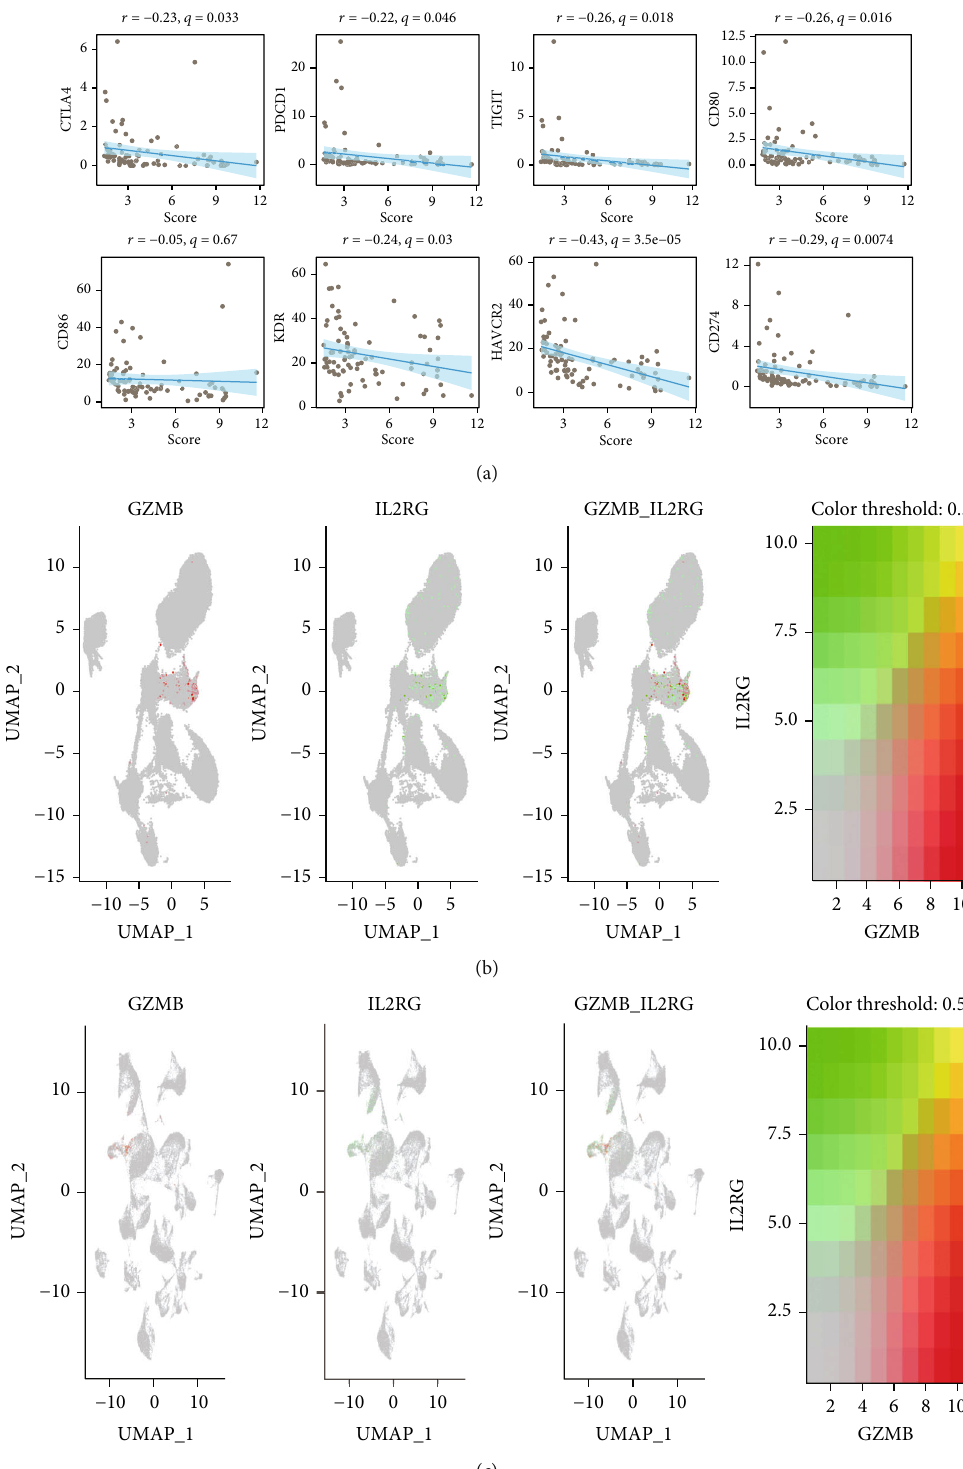
Figure 7: Correlation of risk scores with immune checkpoints and validation of risk genes. (a) Correlation analysis of immune checkpoints and risk scores. (b) Expression of GZMB and IL2RG in UMAP plots of OS scRNA-seq data. (c) Expression of GZMB and IL2RG in UMAP plots of leukocyte scRNA-seq